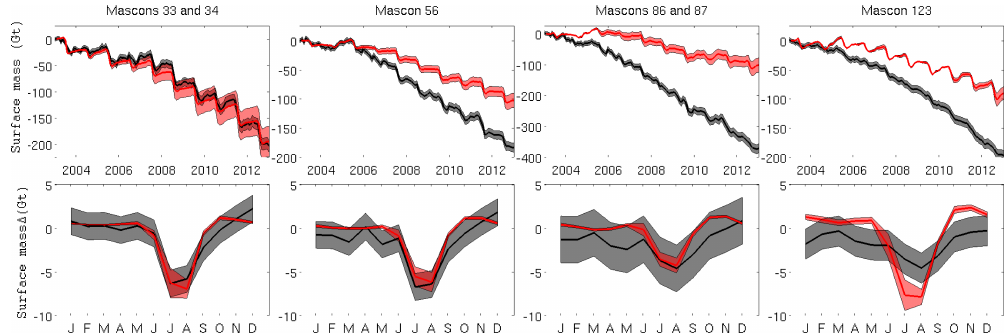
Figure 11. Same as Fig. 8 but for Northwest